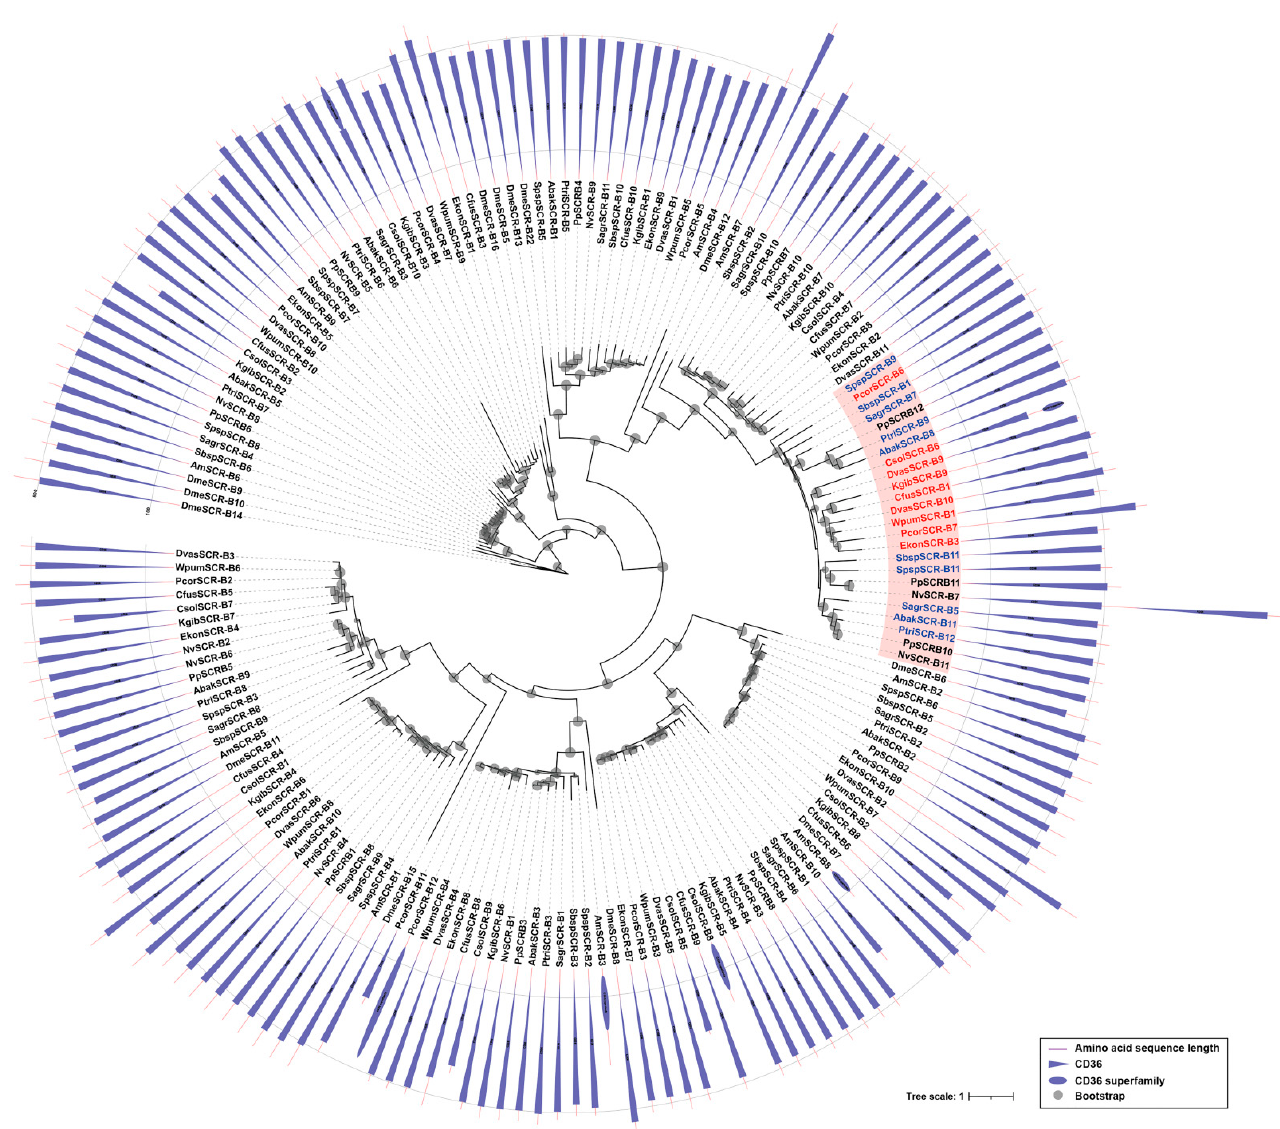
Figure 4. Phylogenetic analysis of SCRBs. The amino acid sequences of SCRBs of 12 fig wasp species (Table S1), D. melanogaster (Dme), A. mellifera (Am), N. vitripennis (Nv), P. puparum (Pp) were used to construct the maximum likelihood tree, and the optimal model was LG+F+R8. The duplicated genes in non ‐ pollinators were filled in pink background, the pollinators were presented in red, and the non ‐ pollinators were presented in blue. Domains of SCRBs were showed in the outer ring. CD36 was represented by a triangle, and the CD36 superfamily was represented by an oval.